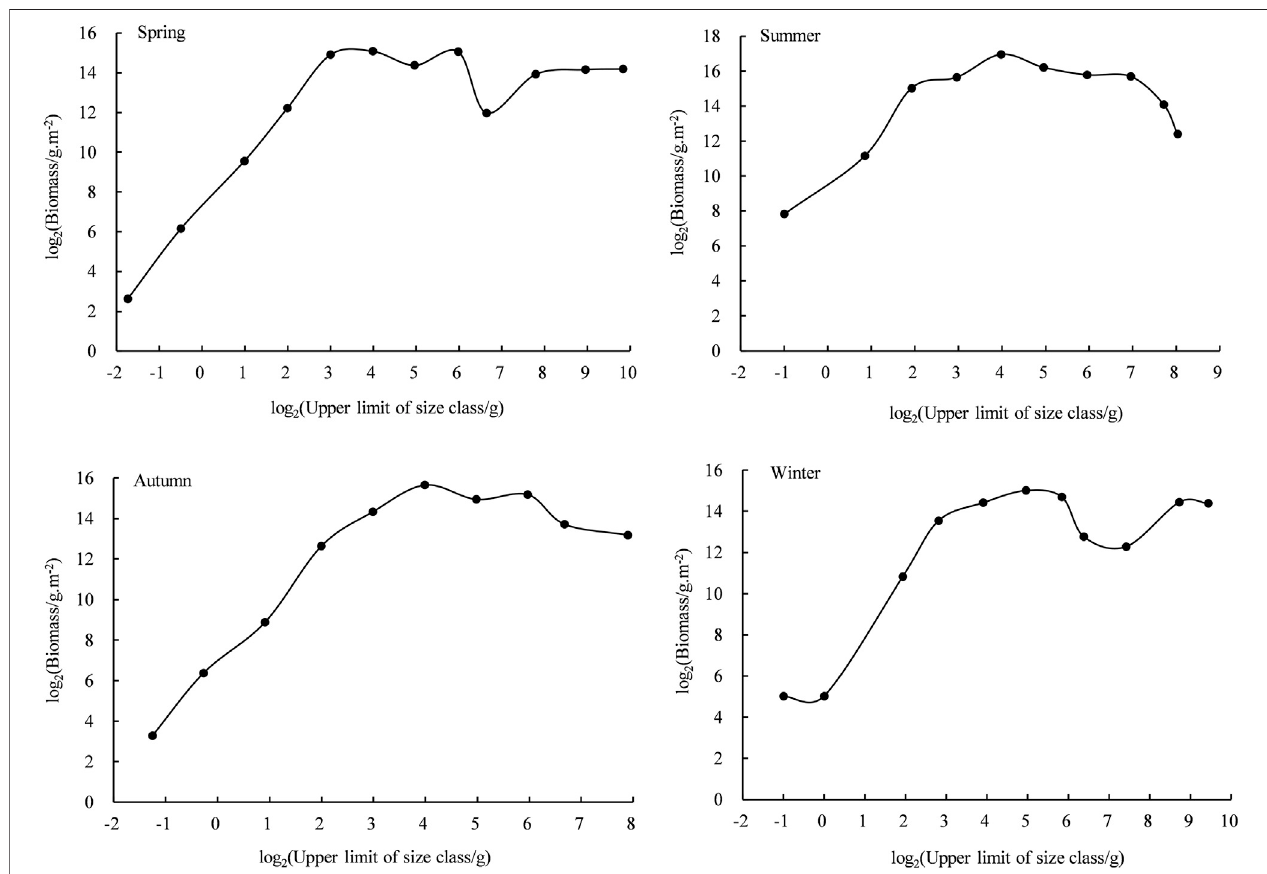
FIGURE 6 | Biomass size spectra of fi shes in every season in Daya